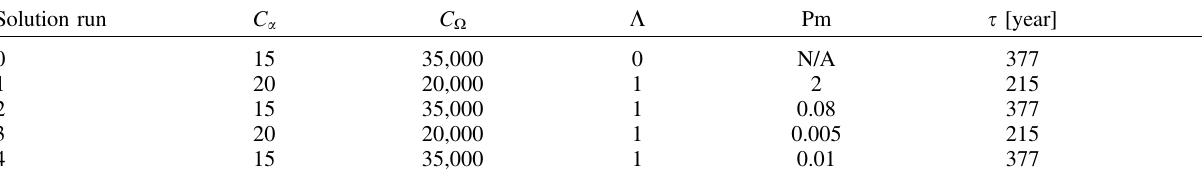
Table 1. De fi ning dimensionless parameters for the reference dynamo solutions discussed in the text. Solution run